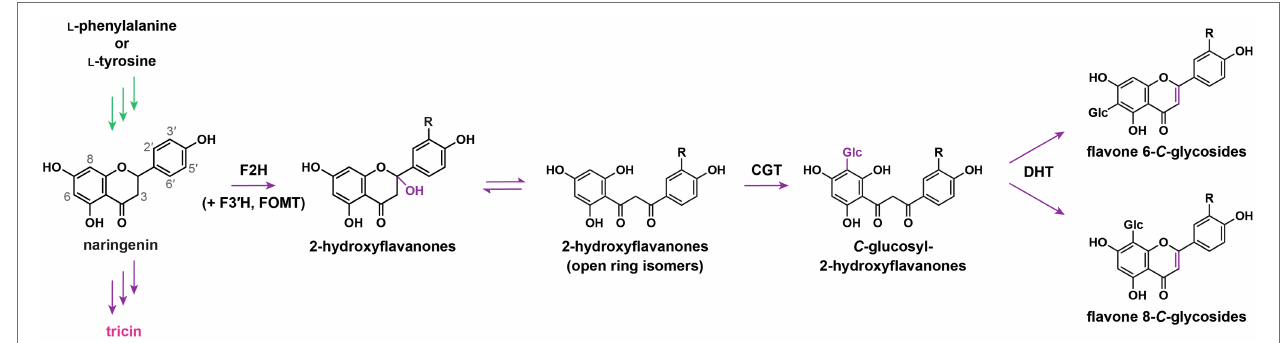
FIGURE 3 | Flavone C -glycoside biosynthetic pathway. F2H, flavanone 2-hydroxylase; F3 ' H, flavonoid 3 ' -hydroxylase; FOMT, flavonoid O -methyltransferase; CGT, C -glycosyltransferase; DHT, dehydratase; and Glc, glucose. R: H, OH, or OCH 3 . In green: general phenylpropanoid pathway. In purple: flavonoid biosynthetic